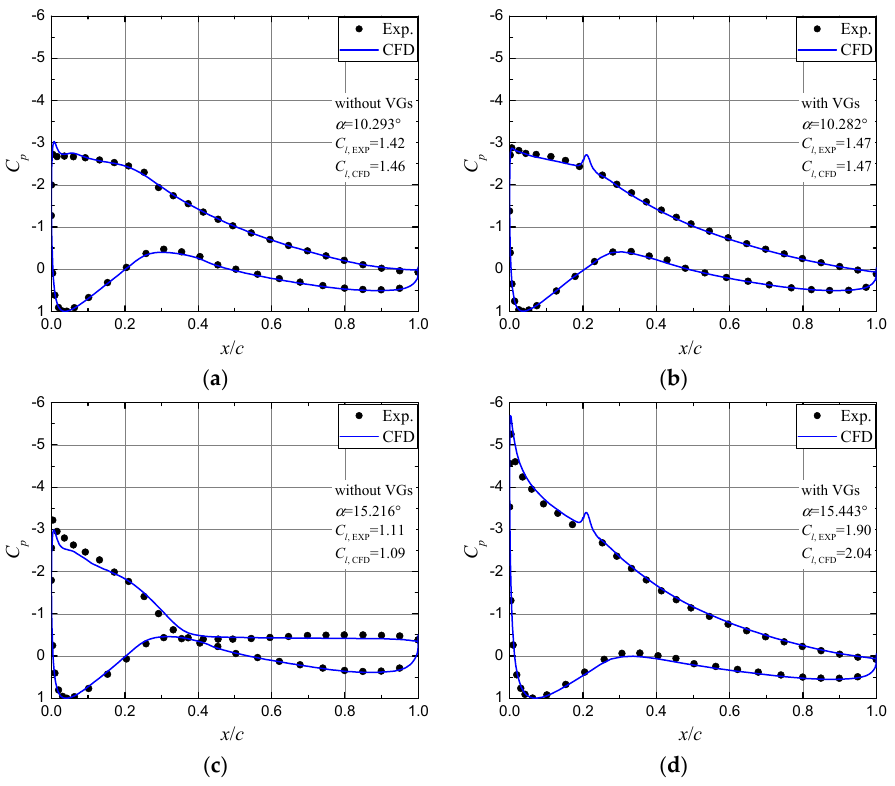
Figure 7. Comparison of the calculated and experimental pressure distributions with and without the baseline VGs: ( a ) α = 10 ° without VGs; ( b ) α = 10 ° with VGs; ( c ) α = 15 ° without VGs; ( d ) α = 15 ° with VGs.